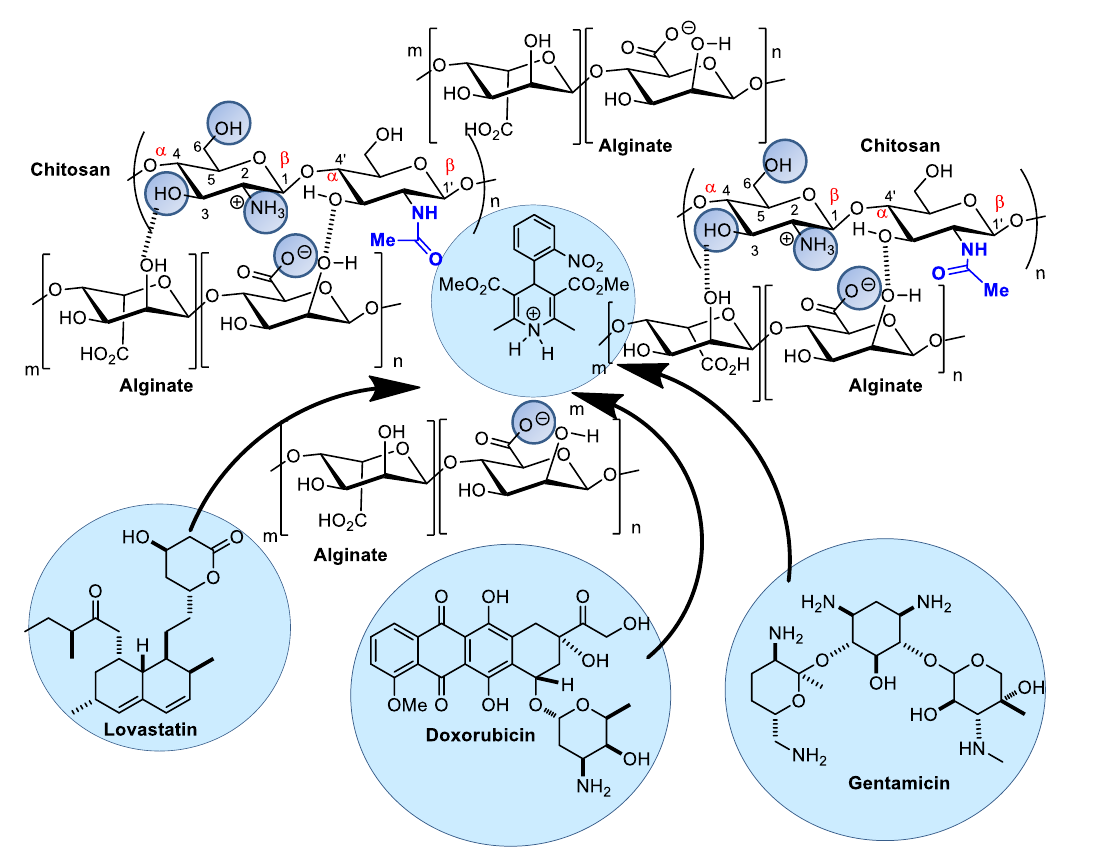
Figure 7. Alginate/chitosan nanocomposites as drug carriers can load several pharmaceuticals, such as lovastatin, doxorubicin, and gentamicin.